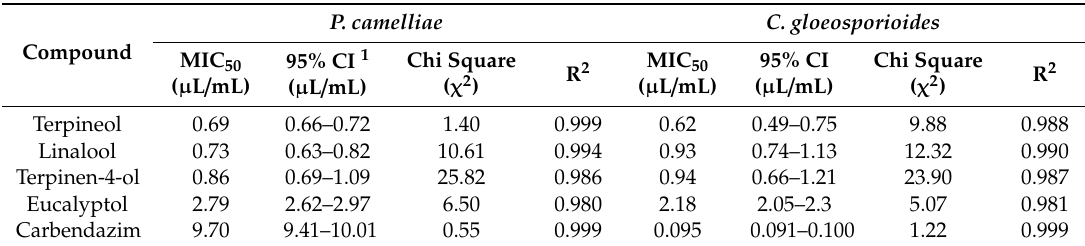
Table 3. Contact antifungal toxicity of the four major chemical compounds of B. frutescens leaf SFE-CO 2 extracts against P. camelliae and C. gloeosporioides